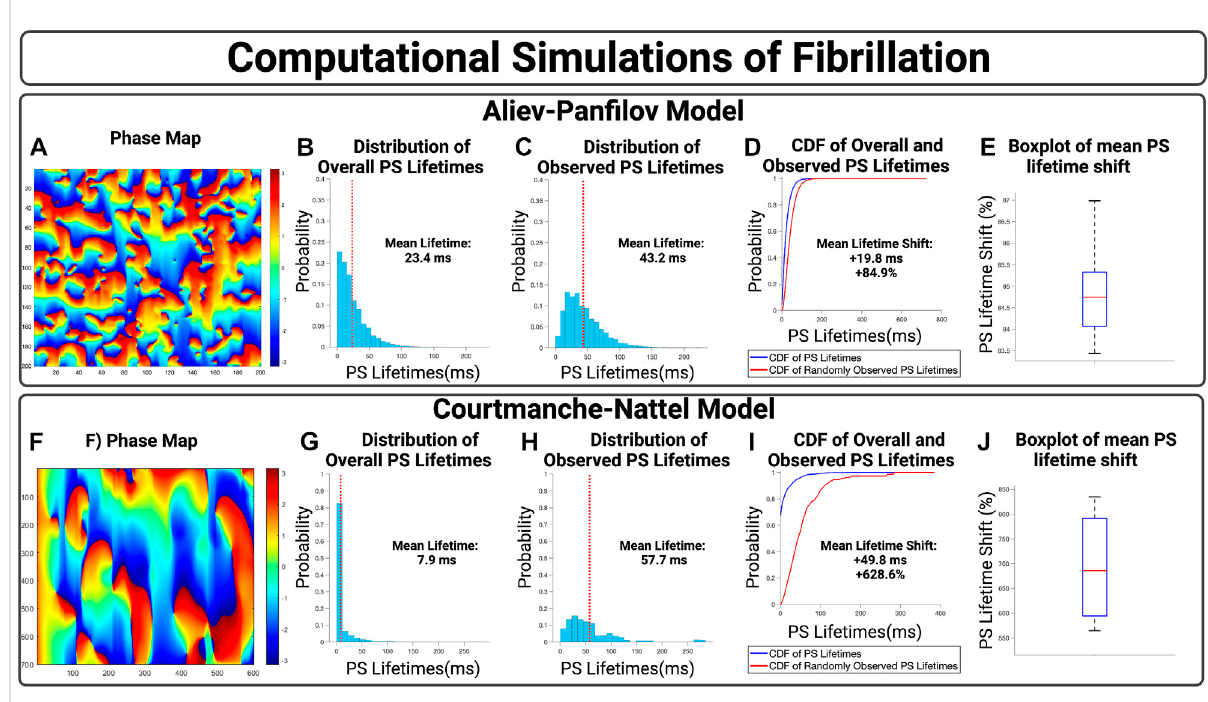
modelsystems. (C,H) Demonstratethedistributionofobserved PSsampledatthe10,000commencementtimepoints. (D,I) Presentsthecumulative distribution functions (CDF) of the overall and observed PS lifetimes. (E) shows the boxplot of mean lifetime shifts across n = 10 APV cases, with an increaseinthemeanPSlifetimeof+19.7 ms(95%CI,±0.1 ms)andanoveralllifetimeshiftof+84.9%(95%CI,±0.3%).( p < 0.001forobservedvs. overall). (F – I) presents an example case of a 2D computational model of fi brillation. (J) For n = 4 cases, there was an increase in mean PS lifetimes